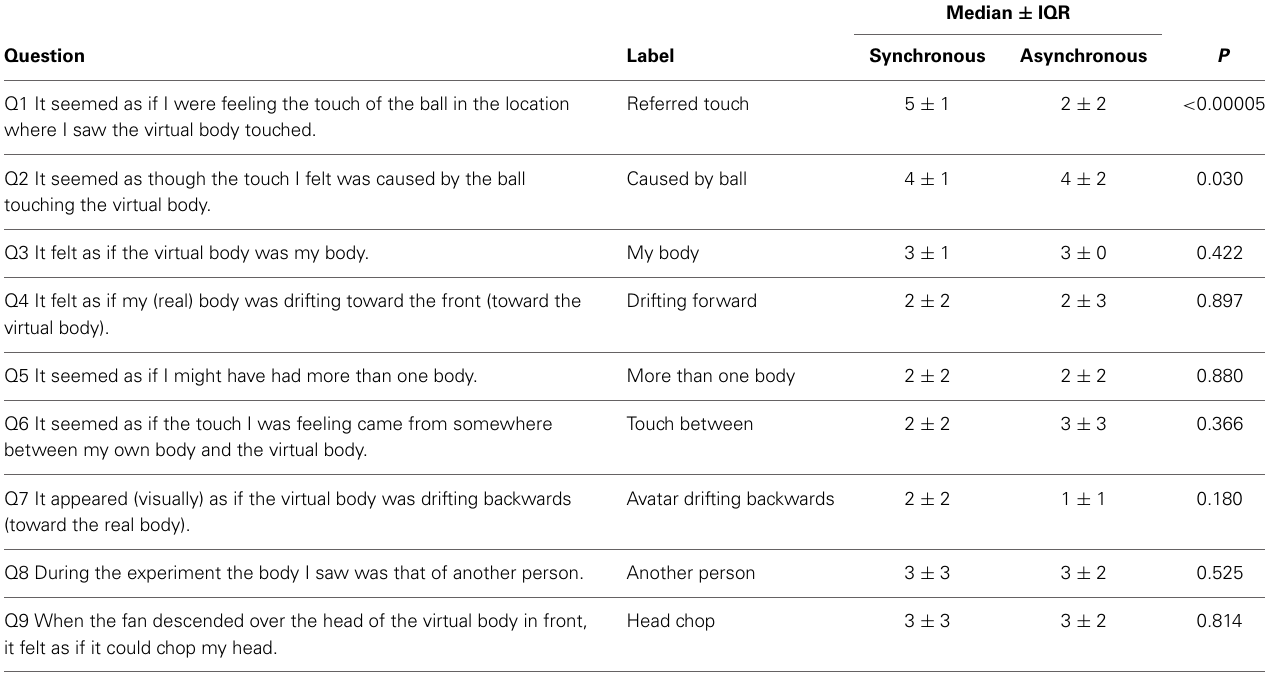
Table 1 | Questionnaire